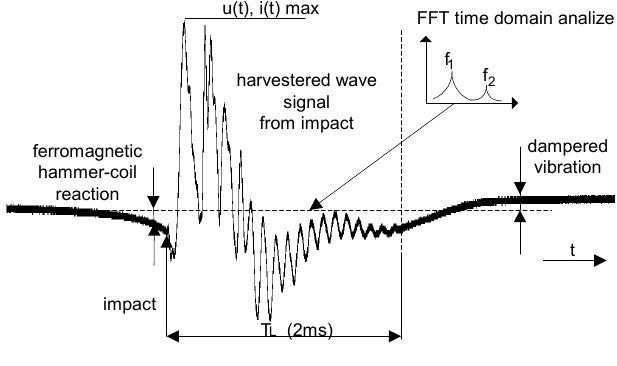
Figure 4. Example of a waveform obtained from TCCM.